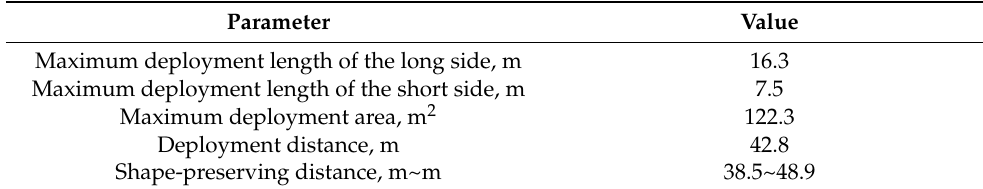
Figure 15. Tether-net deployment performance. (a) Launch distance. (b) Deployment length of long side. (c) Deployment length of short side. (d) Deployment area. Table 3. Deployment parameters.